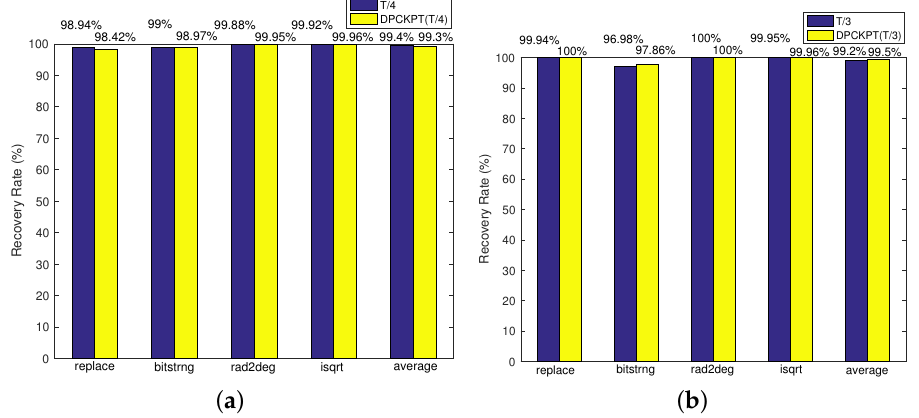
Figure 13. ( a ) The result of the recovery rate of the periodic checkpointing recovery approach with a checkpoint interval of T/4 and that of DLCKPT that redeploys the checkpoints of checkpoint interval of T/4. ( b ) The result of the recovery rate of the periodic checkpointing recovery approach with a checkpoint interval of T/3 and that of DLCKPT that redeploys the checkpoints of checkpoint interval of